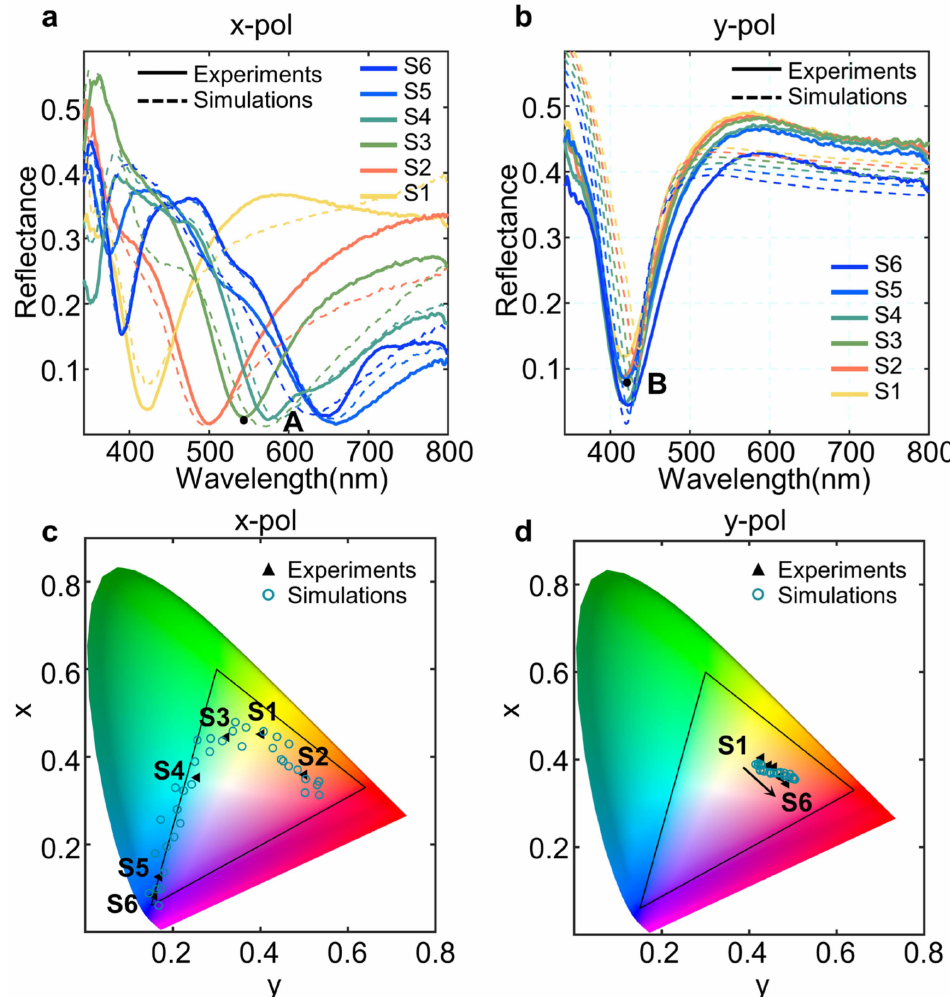
Figure 2. Simulated and experimental reflection spectra under ( a ) x- and ( b ) y-polarization light. Corresponding CIE 1931 chromaticity coordinates for ( c ) x- and ( d ) y-polarization,